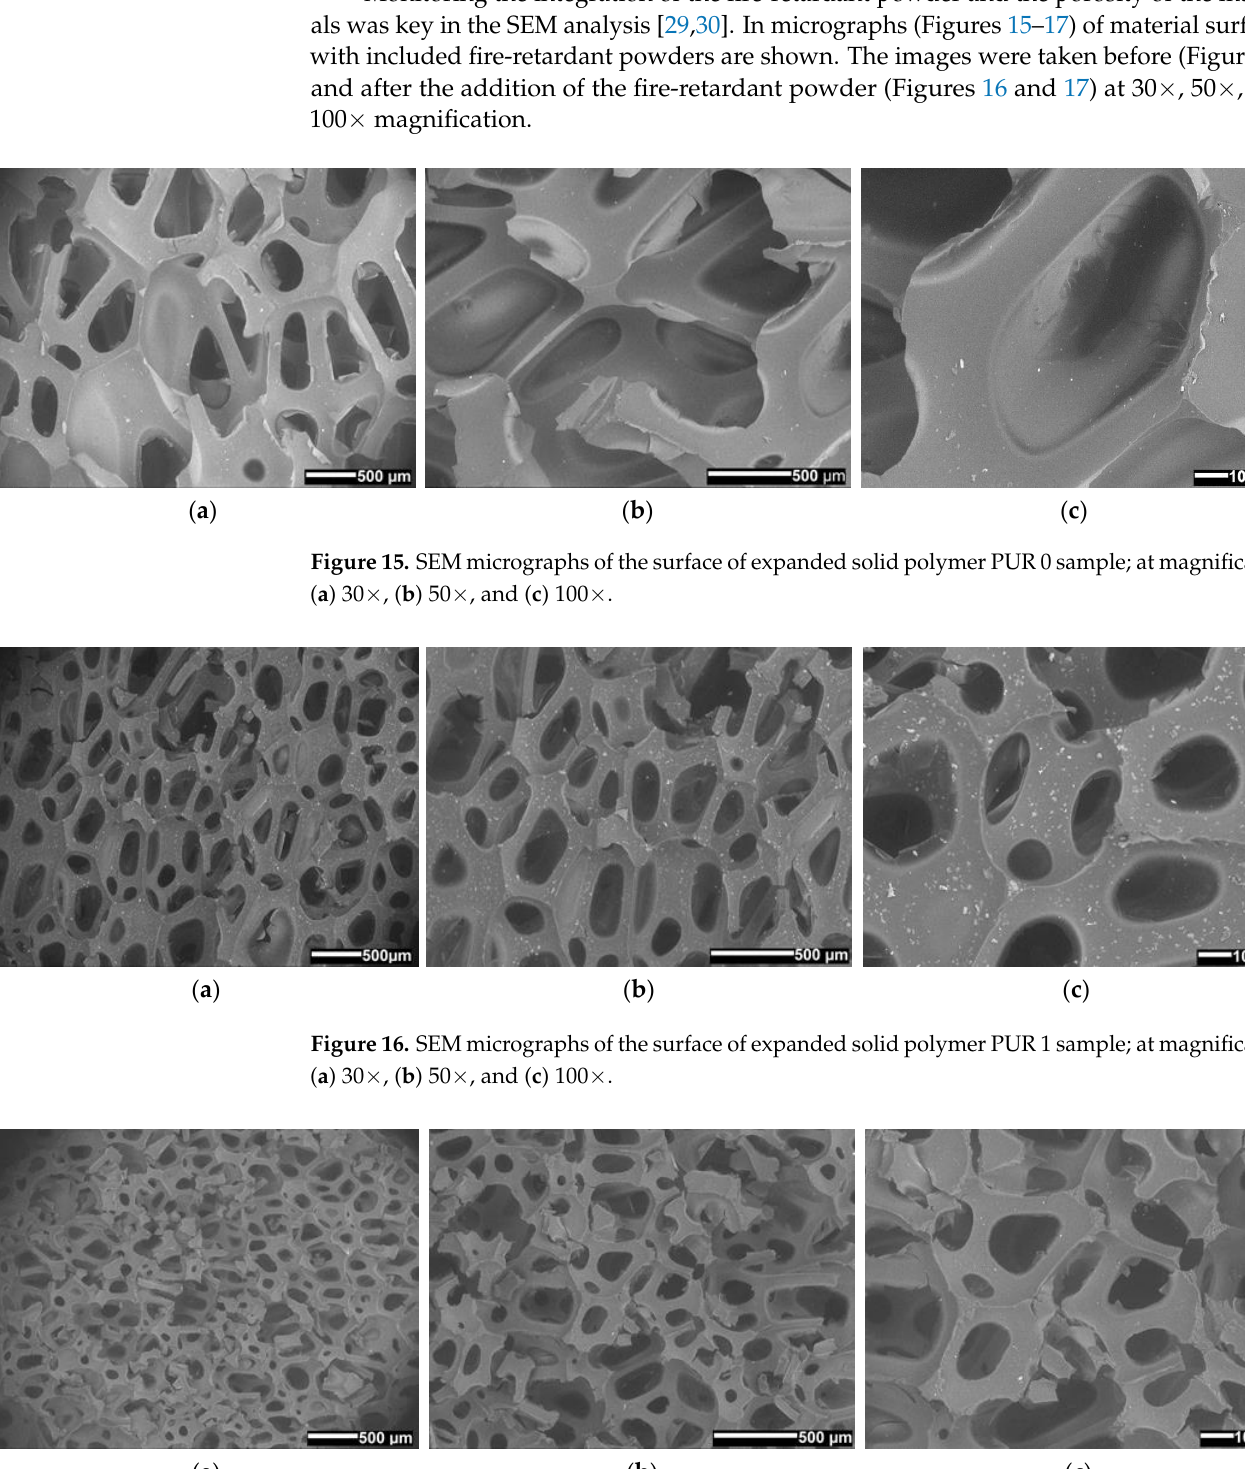
Figure 17. SEM micrographs of the surface of expanded solid polymer PUR 2 sample; at magnifi- cation ( a ) 30×, ( b ) 50×, and ( c ) 100×.